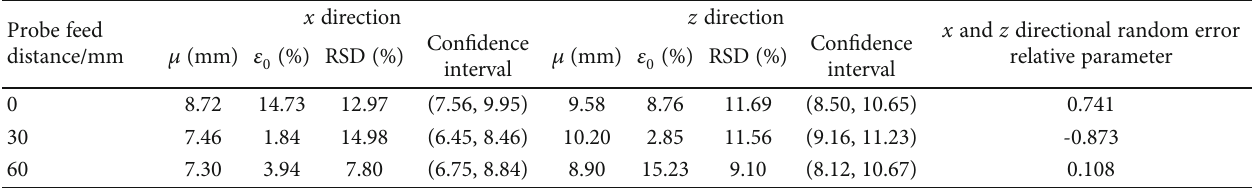
Table 4: Analysis result of pitching angle of remote center point